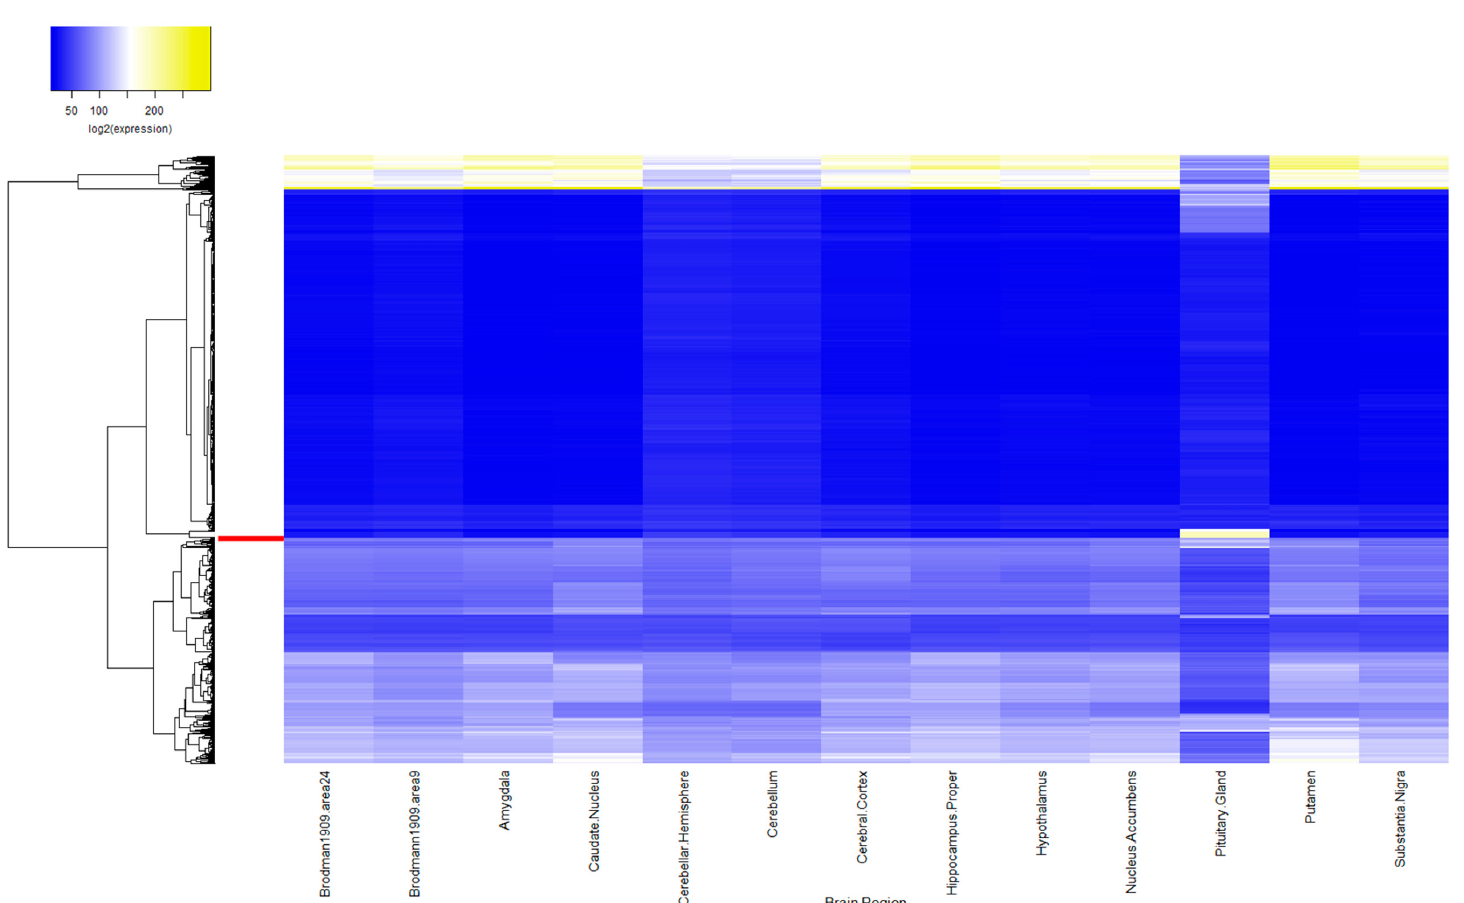
Figure 1. Brain Expression Profiles of ASD Candidate Gene Set and Random Gene Sets. Shown are average expression levels for ASD and random gene sets, based on transcripts per million, for each brain region obtained from typical human tissue in GTEx. Average expression of each gene set in the respective brain region are clustered based on Euclidean measures. The ASD risk gene cluster has been amplified for easier visualization and is highlighted in red on the y-axis.